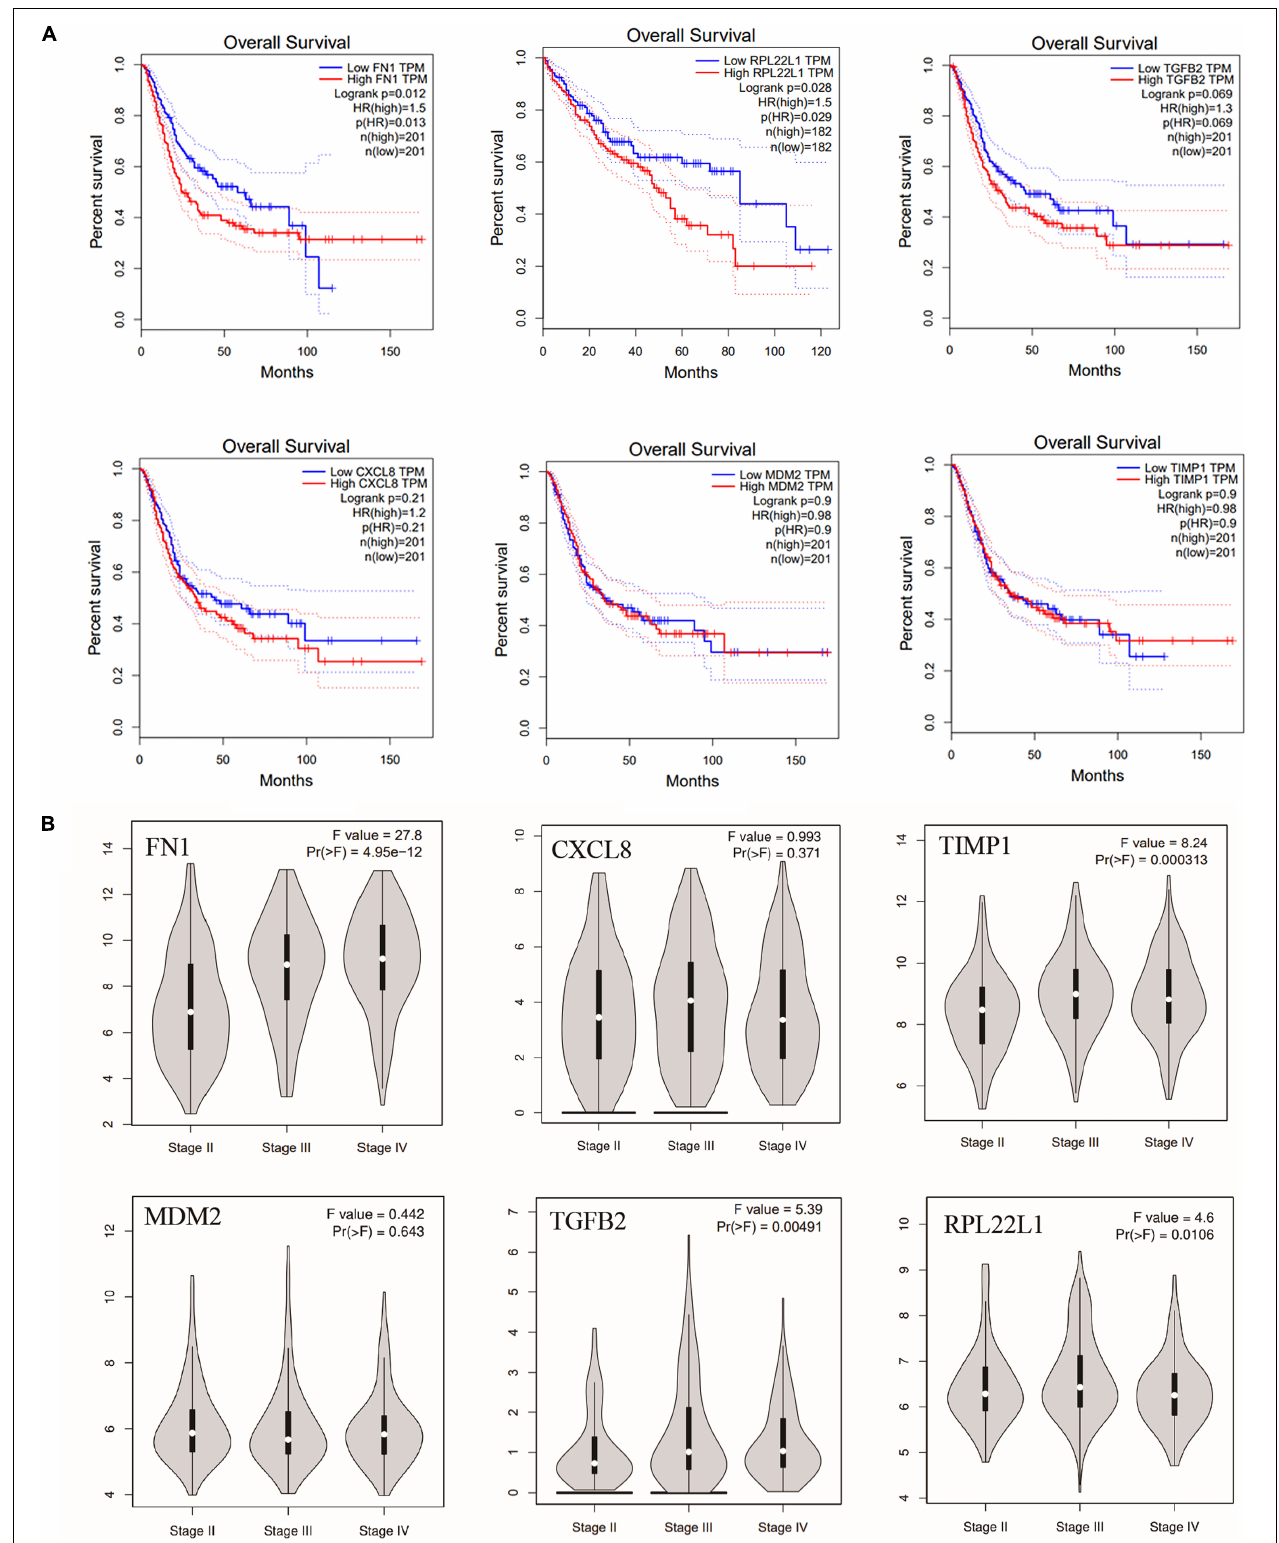
FIGURE 7 | (A) Overall survival of the six hub genes in bladder cancer based on TCGA database, including FN1, MDM2, TGFB2, CXCL8, TIMP1, and RPL22L1. OS: overall survival. (B) The effect of six hub genes on bladder cancer stage.